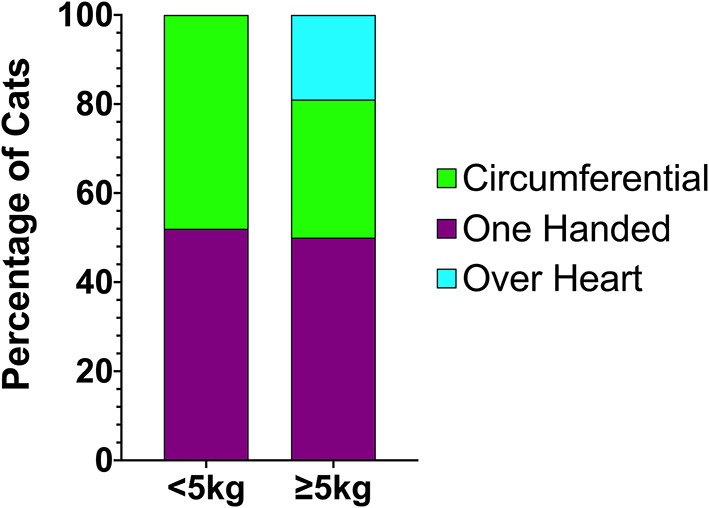
Chest compression techniques applied to cats during CPR according to body weight. CPR, cardiopulmonary resuscitation.